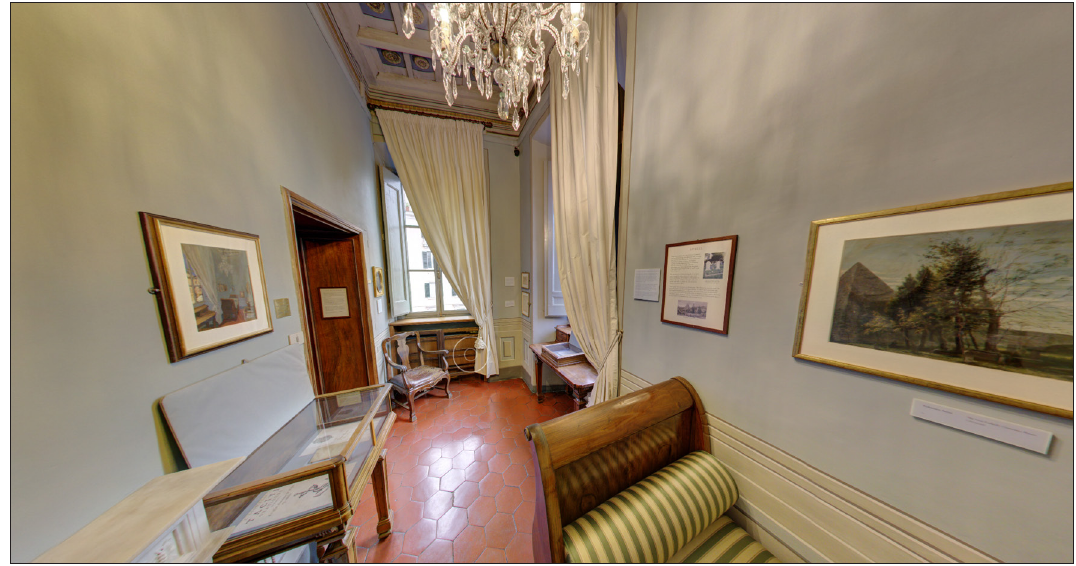
Fig. 3 : The Keats Room of the Keats-Shelley House, photographed from ‘A Panoramic Tour of the Keats-Shelley House’ created by Twiceout and launched for the bicentenary of John Keats’s death in February